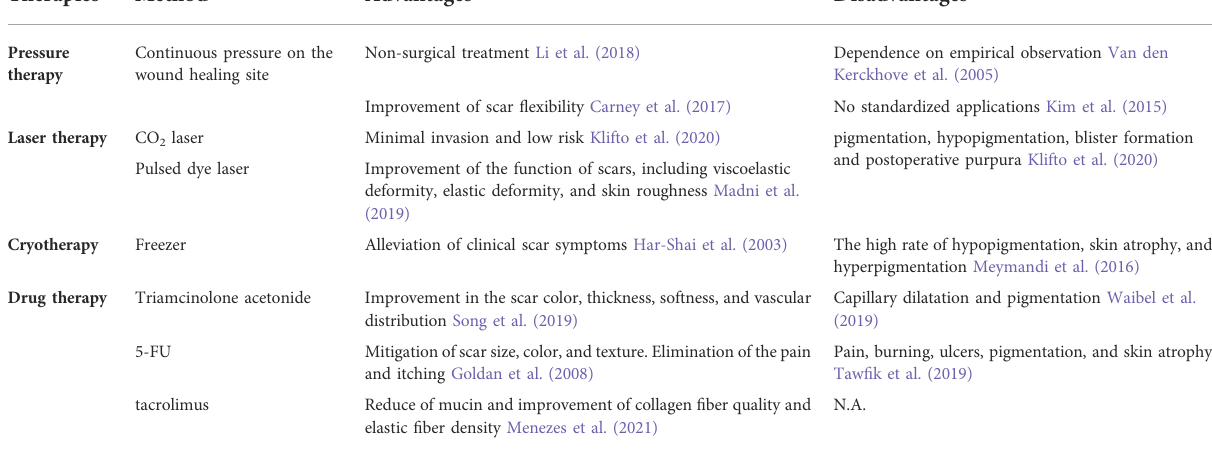
TABLE 1 Current treatment methods for